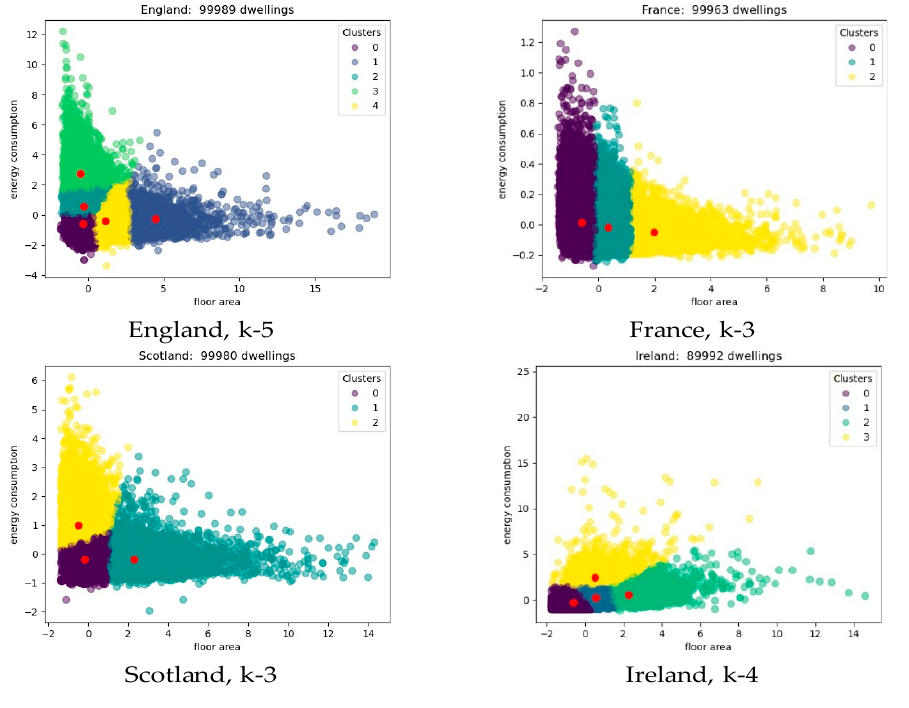
Figure 6. k ‐ means clusters for each country. Figure 6. k-means clusters for each country.